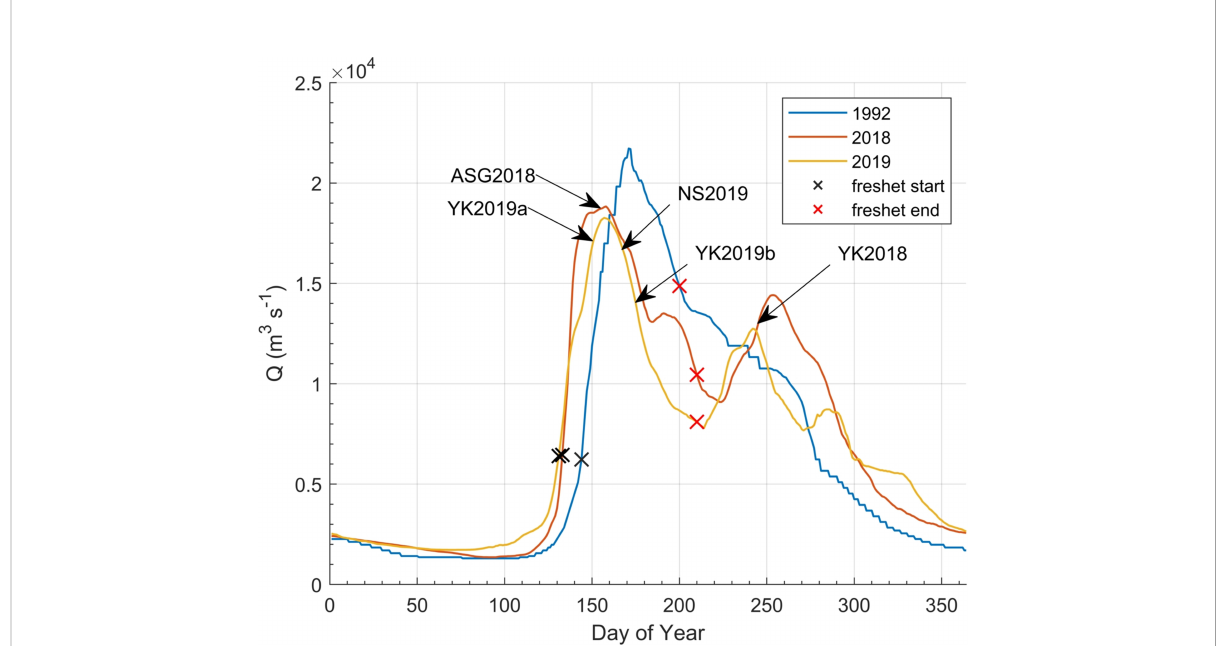
FIGURE 2 Yukon River annual hydrographs at Pilot Station, AK for the years 1992, 2018 and 2019 for daily mean stream fl ow (Q m 3 s -1 ). The arrows mark the fi eld deployment start dates for 2018 and 2019. The black X ’ s refer to the computed start of the freshet determined from the modi fi ed Cayan et al., 2001 method and the red X ’ s show the end of the freshet determined from the centroid of the hydrograph computed by equation 13 (See methods for details). The year 1992 represents the median freshet start date for years prior to